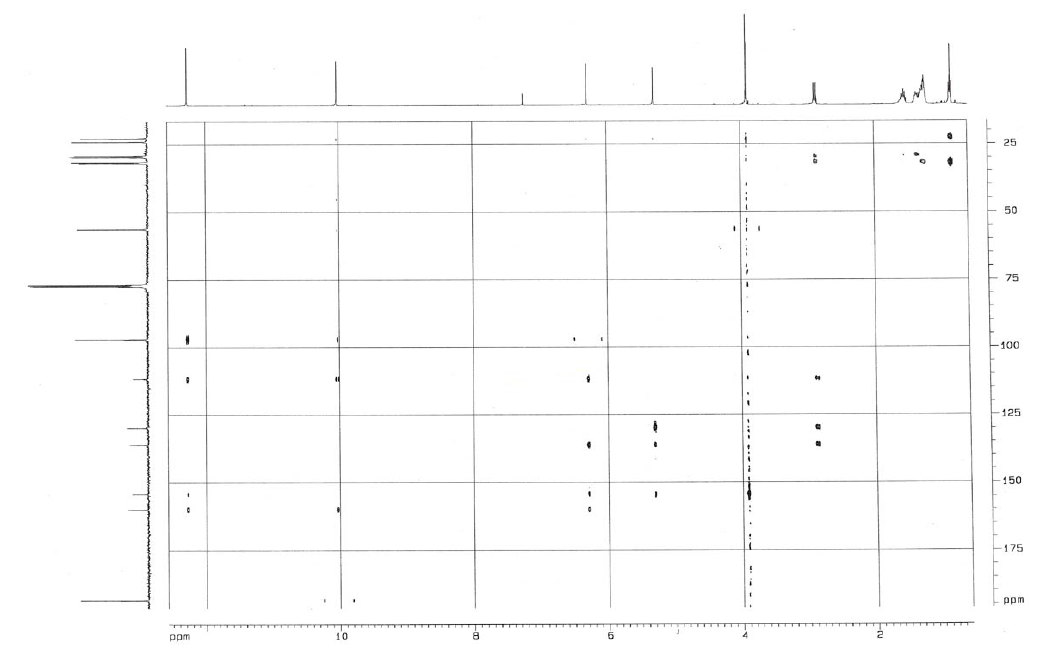
Figure 1 . The HMBC spectra of ( 1